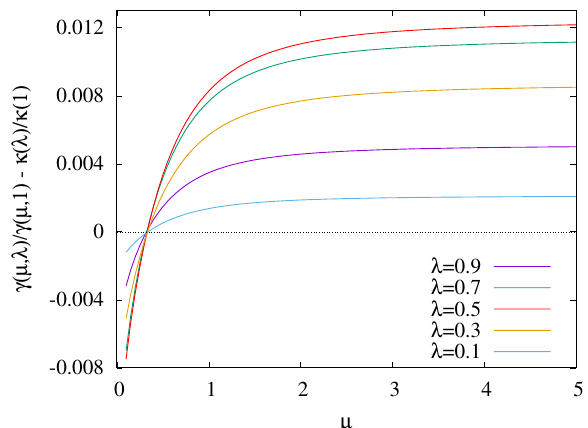
Figure 8: Deviation of the slope ratio from the CFT prediction with n = 1, plotted in the regime 0.1 ≤ µ ≤ 5 for various fixed values of λ